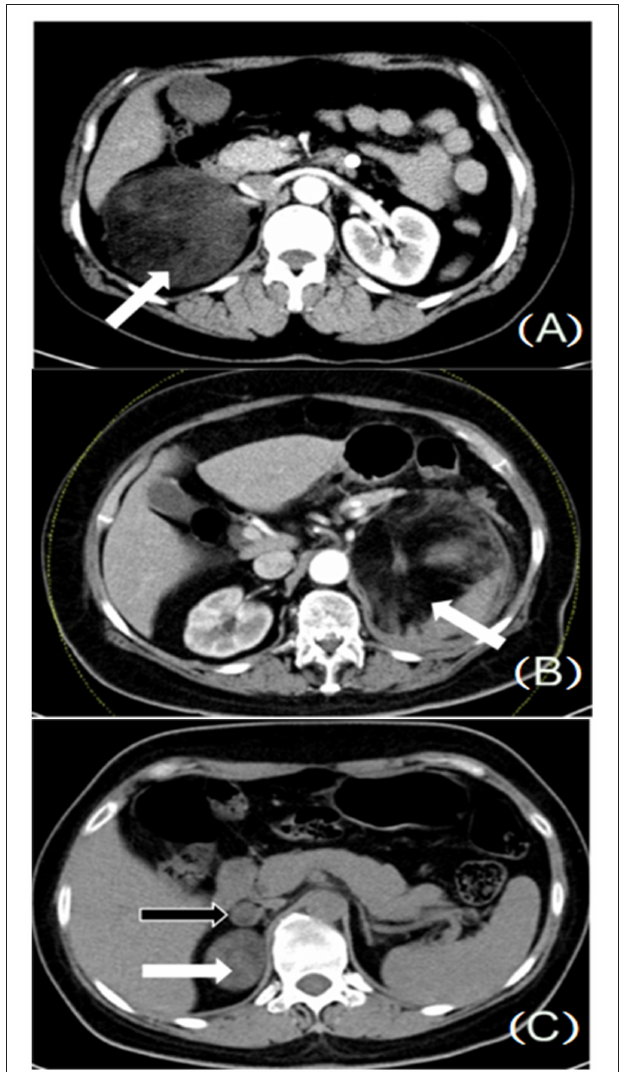
FIGURE 1 | (A) Huge adrenal neoplasm, located on the right side (white arrow). (B) Huge adrenal neoplasm, located on the left side (white arrow). (C) Multiple adrenal neoplasms, located on the right side (white and black arrows).